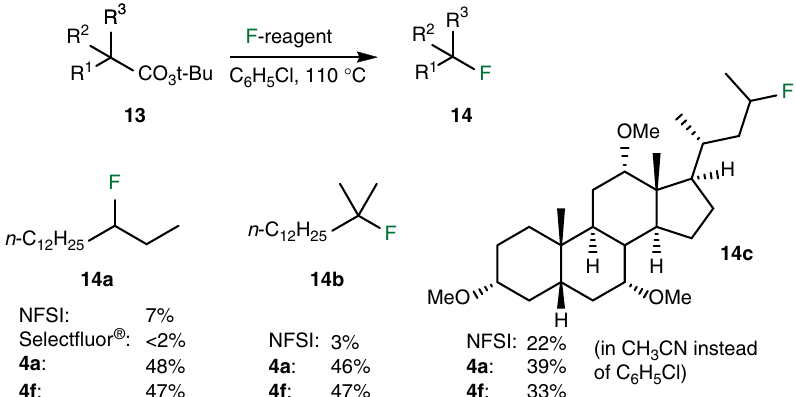
Fig. 7 Decarboxylative fl uorination of tert -butyl peresters. The fl uorinating reagents of the second generation provide the desired fl uorides in signi fi cantly lower yield than the one of the third generation due mainly to the formation of alkene side products